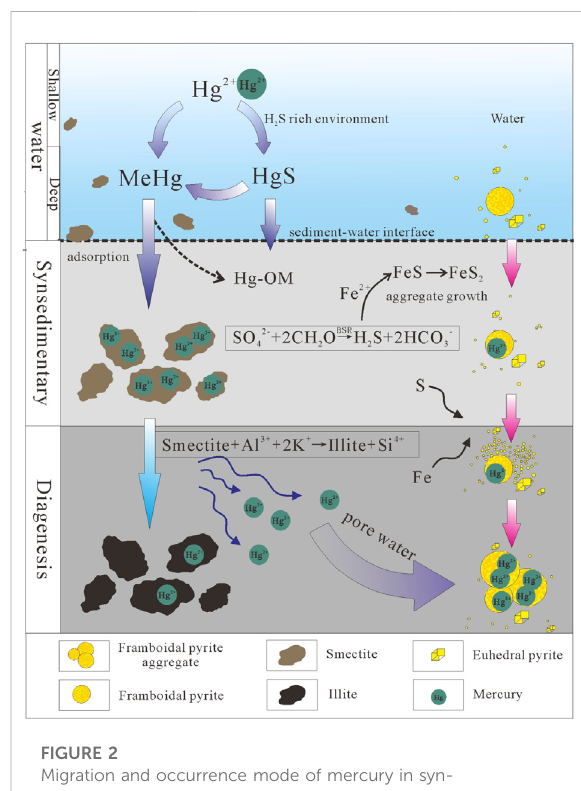
FIGURE 2 Migration and occurrence mode of mercury in syn- sedimentary and diagenetic